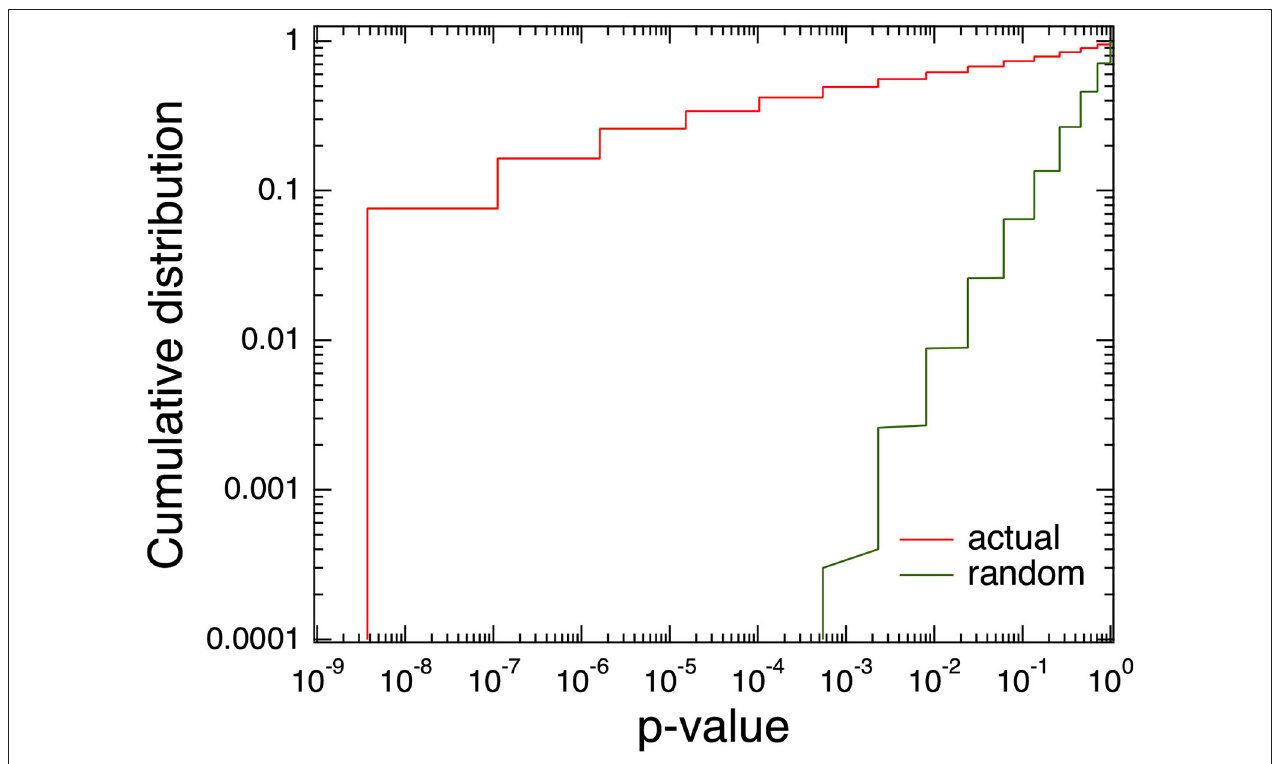
FIGURE 4 | Cumulative distributions of p -values for Core 30, Large 70, and Mid